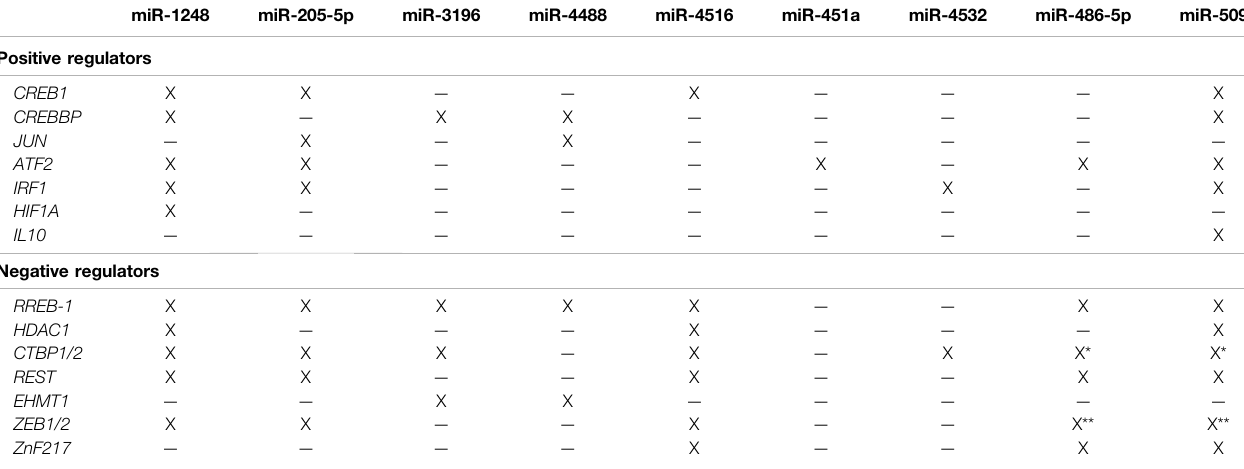
TABLE 3 | Positive and negative regulators of HLA-G expression potentially targeted by the DE-miRNAs in childhood ALL, encompassing high marrow sHLA-G